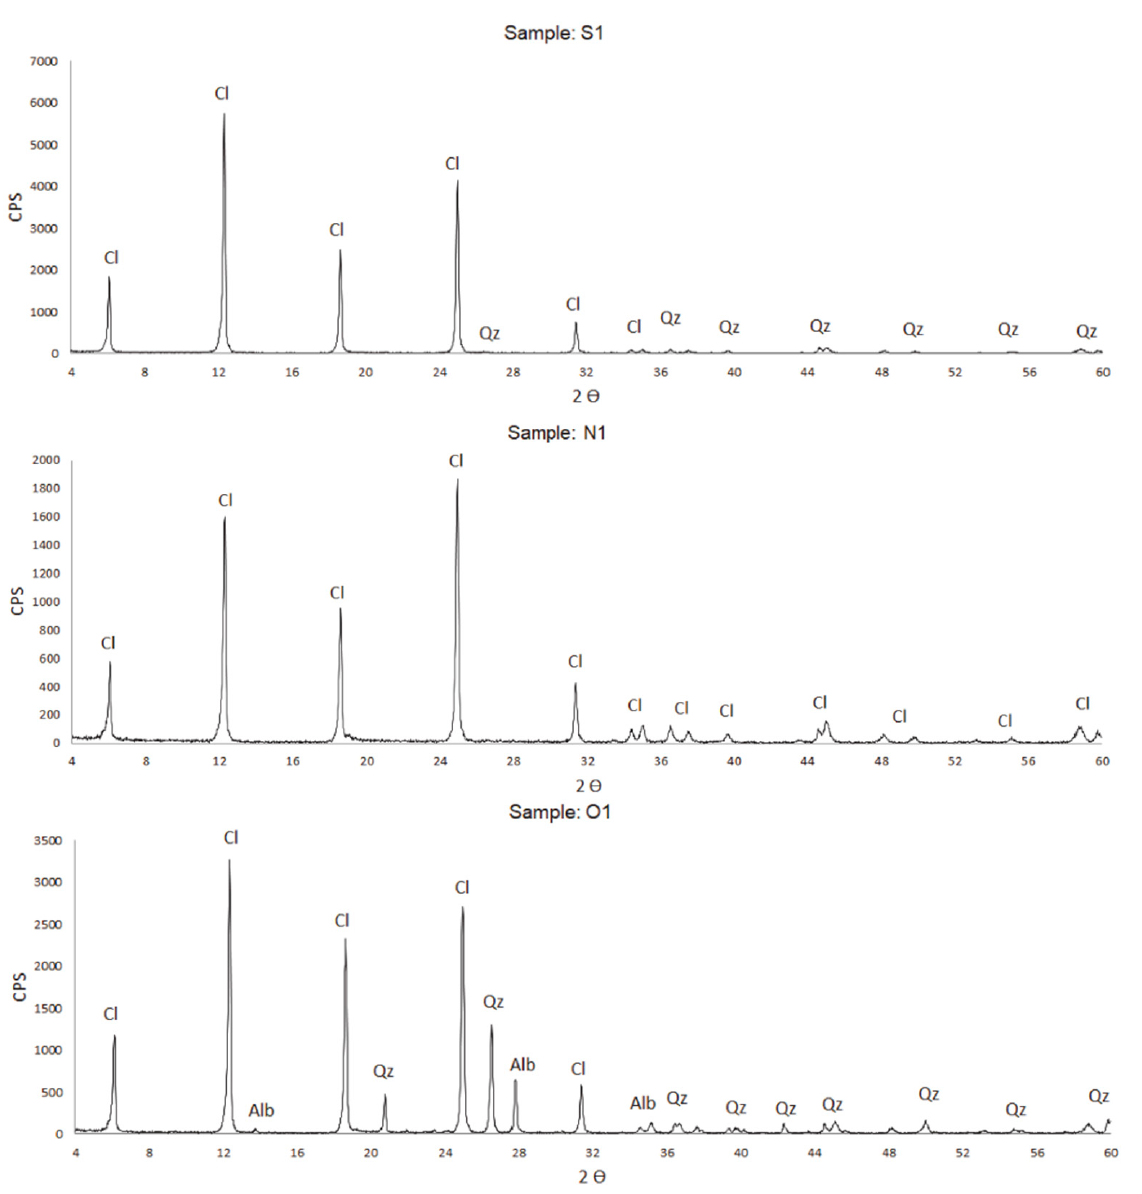
Figure 7. XRD analysis of stone moulds Sample S1, Sample N1 and a compatible rock material (Sample O1). Cl = clinochlore; Qz = quartz; Alb = albite.